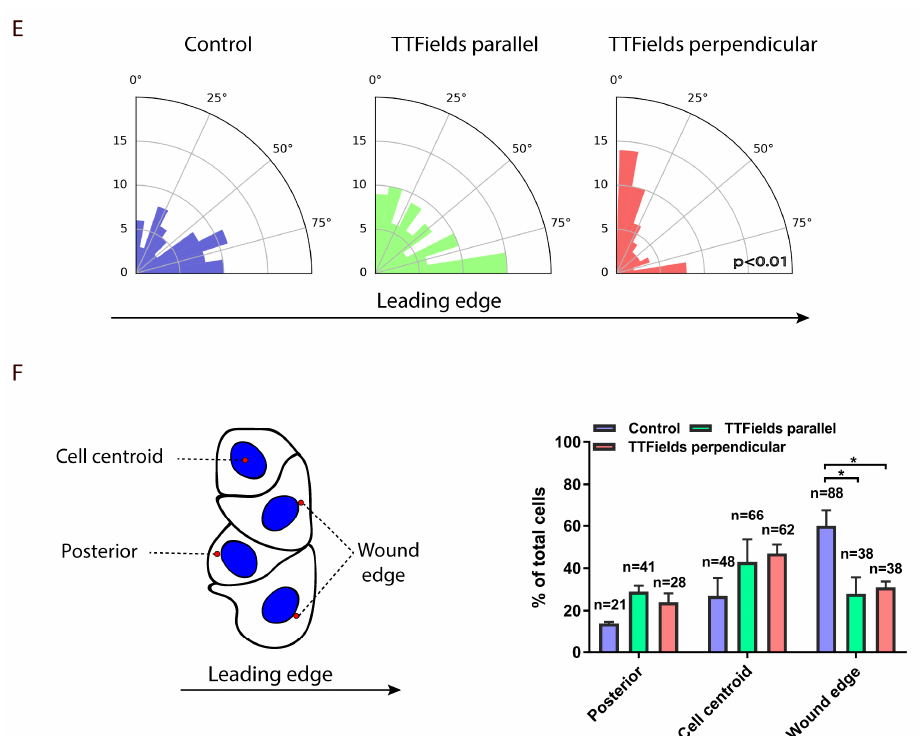
Figure 3. Microtubule assembly and directionality is perturbed by TTFields ( A ) A cell-free gap was created in the LN-299 glioblastoma cell monolayer and TTFields were applied for 7 h uni-directionally, using one pair of transducer arrays (as in Figure 2C–E). Scale bars: 20 µ m. Blue, DAPI-stained DNA; Green, α -tubulin; Red, γ -tubulin (microtubule-organizing center (MTOC)). White arrows indicate cells in small micrographs, Magenta arrows indicate MTOC. Quantitative analysis are depicted of: ( B ) cell spread area, ( C ) total sum of tubulin fluorescence within the cell, ( D ) cell polarity that is defined as the distance from cell nucleus to center of mass, and ( E ) average cell angle relative to the leading edge (90 ◦ ). Y-axis represents the number of cells. Mean + SD; one-way ANOVA, followed by Tukey’s pos t -test. ( F ) Diagram of the wound healing assay showing (left panel) the position of the MTOC (red) relative to the nucleus (blue) and (right panel) the frequency distribution of the position of the MTOC relative to the nucleus and the leading edge. Mean + SEM; two-way ANOVA, followed by Tukey’s pos t -test. * p < 0.05, ** p < 0.01, and *** p <